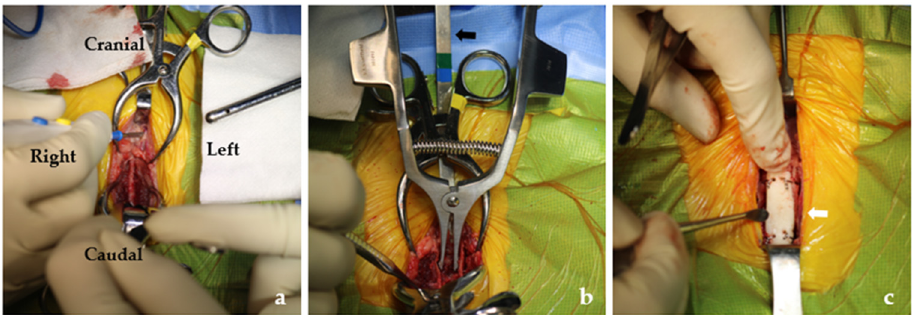
Figure 2. Ventral midline approach with elevation of the gracilis and adductor muscles ( a ). Dis- traction of symphysis is maintained with a distractor and spatula (black arrow) to avoid damaging the organ under the bone ( b ). A polymethyl methacrylate spacer (white arrow) was inserted and secured with a stainless steel wire ( c